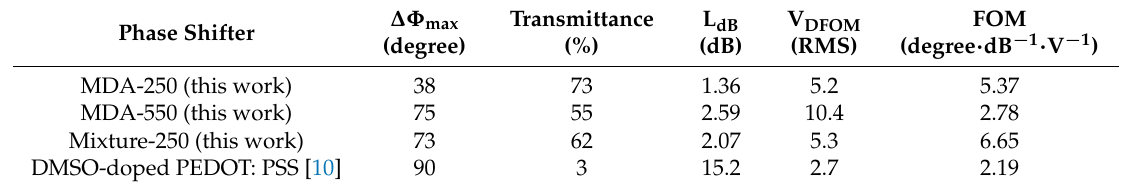
Table 2. Calculated figure of merit (FOM) for all types of PEDOT: PSS-based THz phase shifters at 1